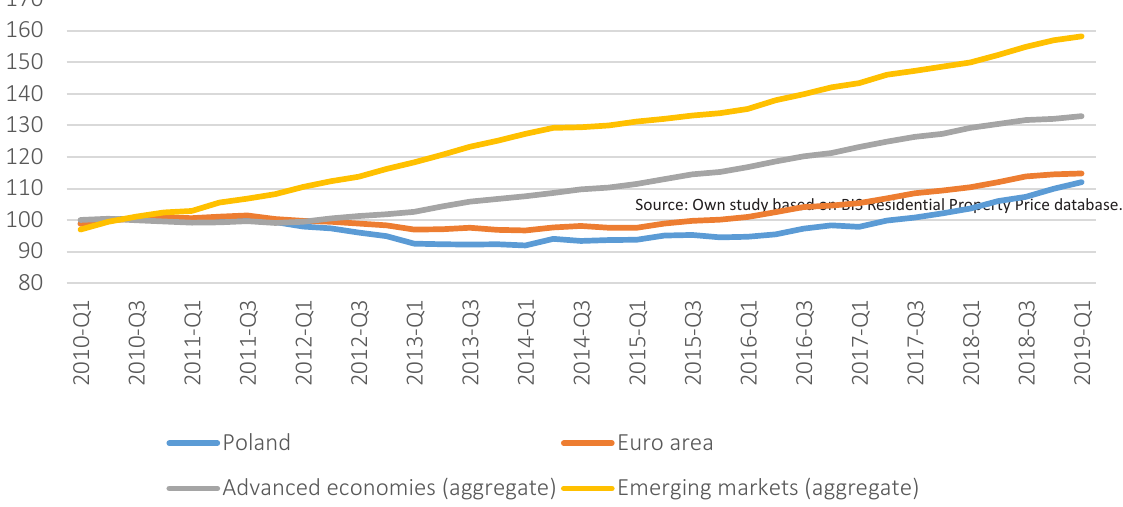
Source: Own study based on BIS Residential Property Price